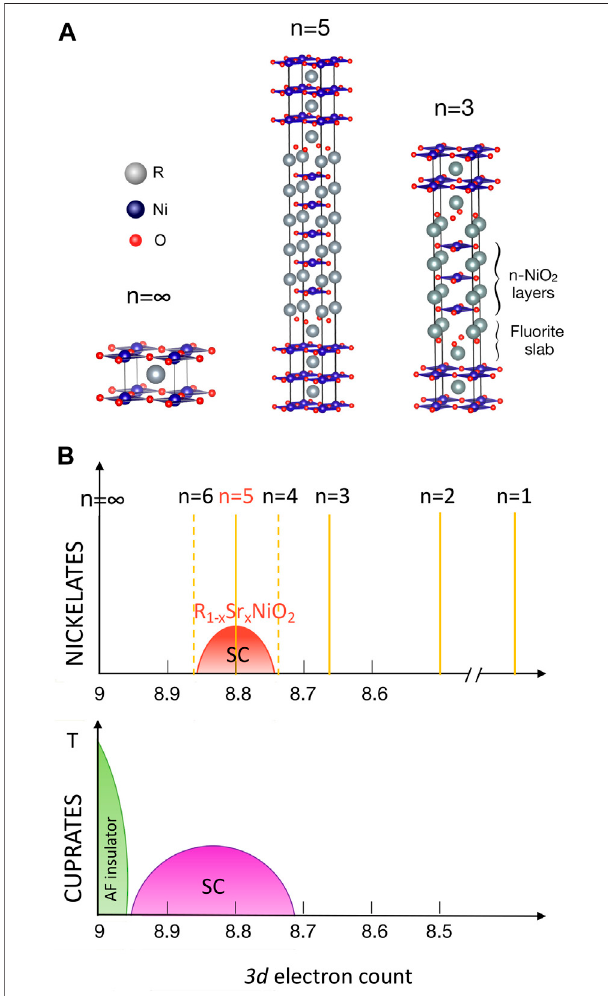
FIGURE 1 | (A) Crystal structures of the n (cid:1) ∞ , n (cid:1) 5, and n (cid:1) 3 layered nickelates highlighting the presence of the n -NiO 2 layers and the fl uorite blockingslabspresentinthe n ≠∞ materials. R ,NiandOatomsareshownin gray, blue, and red, respectively. (B) Schematic phase diagram as a function of nominal d fi lling for layered nickelates (top) and cuprates (bottom), highlighting the regions where superconducting domes have been experimentallyreported.Themembersofthe R n + 1 Ni n O 2 n + 2 seriesaremarked with lines (dashed lines correspond to materials that have not been synthesized yet). The n (cid:1) 5 member falls close to the optimal doping value for both cuprates and the in fi nite-layer nickelate.